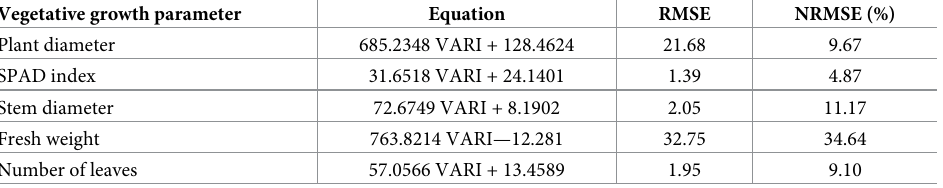
Table 3. Regression models for prediction of lettuce vegetative growth parameters based on the VARI (visible atmospherically resistant index) vegetation index obtained from aerial images of the lettuce